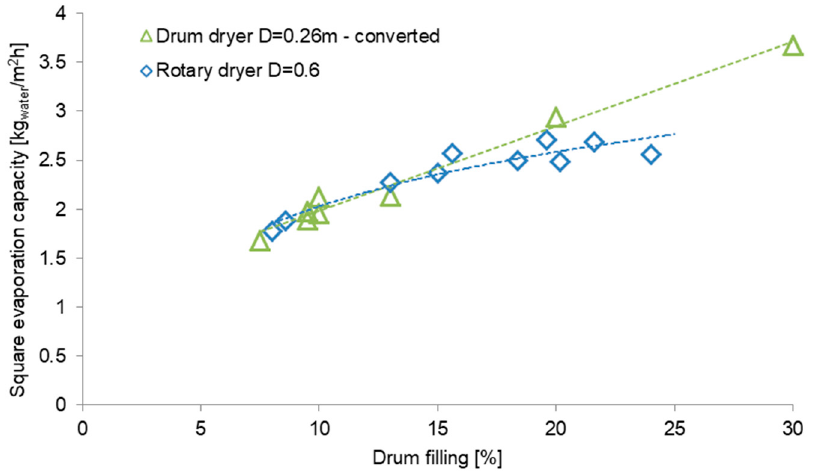
Figure 10. Comparison of square evaporation capacities after geometry correction introduced by Equations (6) and (7).